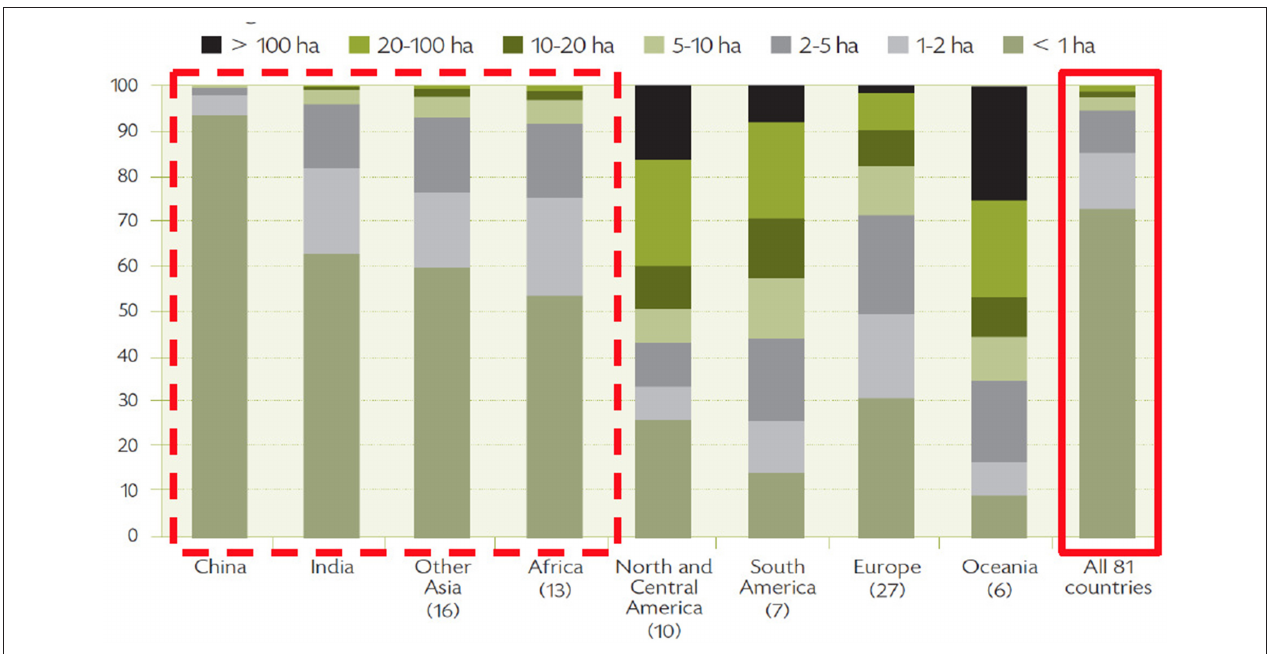
FIGURE 1 | Farm structures by size class in different regions and countries. Adapted from Bélières et al. (2015), p. 67. Numbers in parenthesis under the country/region’s name correspond to the number of harmonized national censuses in the FAO’s WCA 2000 round.